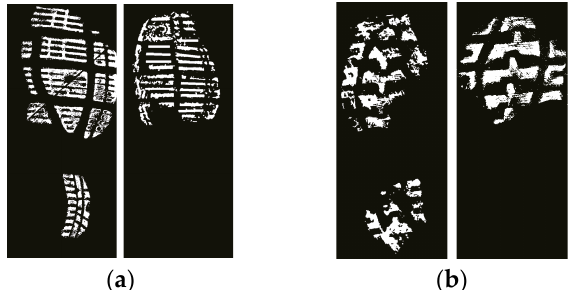
Figure 1. Illustrative cases of a failure by either approach. ( a ) Holistic features may yield more satisfactory results than local features. ( b ) Local features may yield more satisfactory results than holistic features.